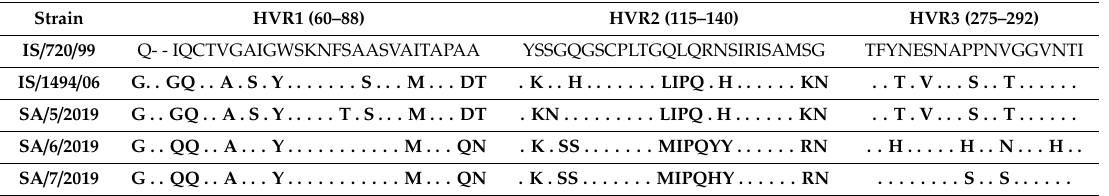
Table 3. Sequence alignment of HVRs amino acid sequences for three reported isolates in this study compared to their parental origin IS / 720 /